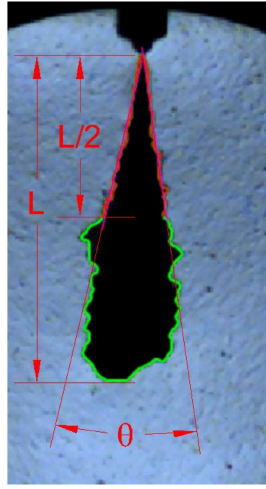
Figure 4. Definition of the spray penetration length L and the spray cone angle ( L ) at L /